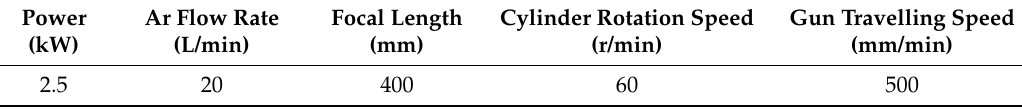
Table 4. Re-melting operation parameters by